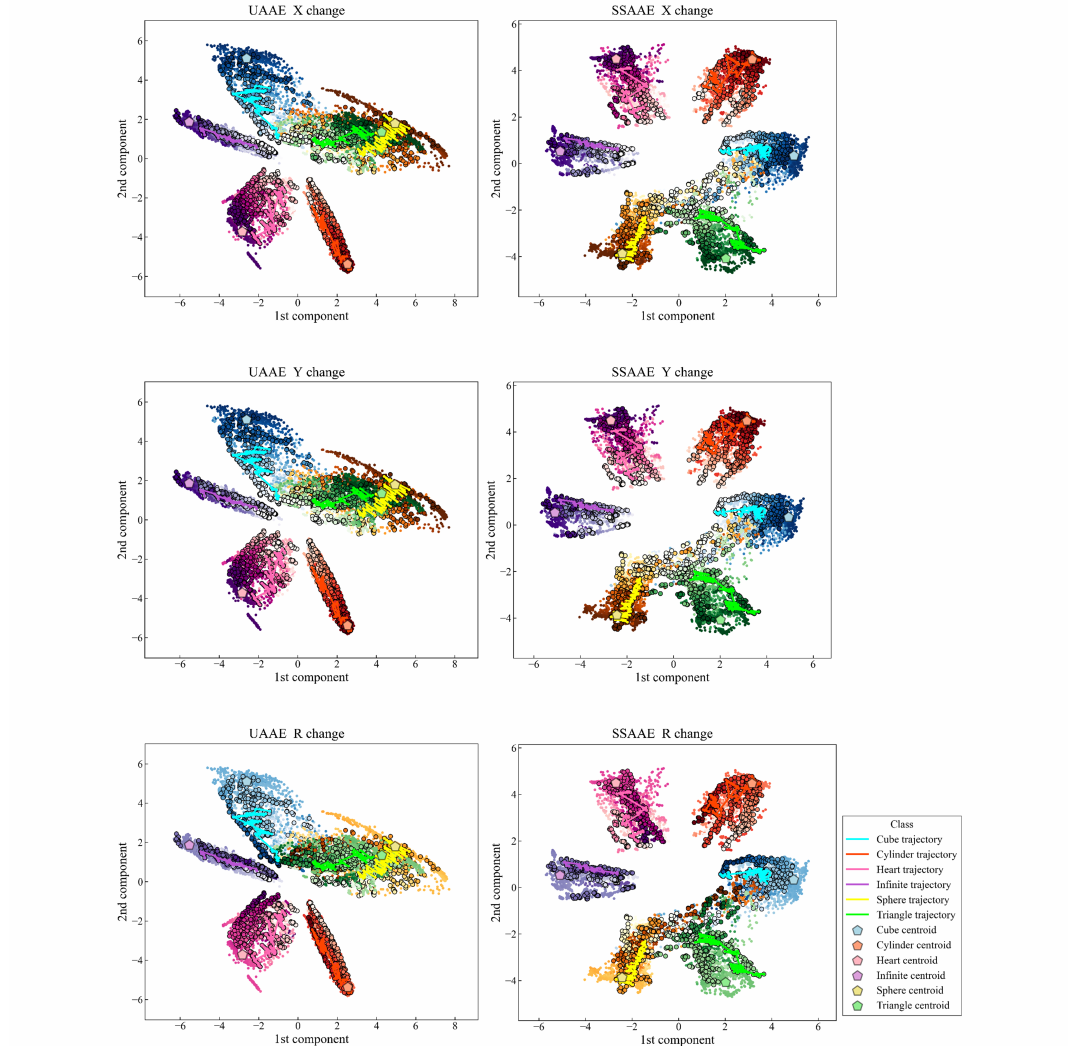
Figure 4. UAAE latent space ( left ) and SAAE latent space ( right ) representation with their corre- sponding gradient information regarding the “augmented parameters” values for horizontal stretch ( top ), vertical stretch ( middle ), and rotation ( bottom